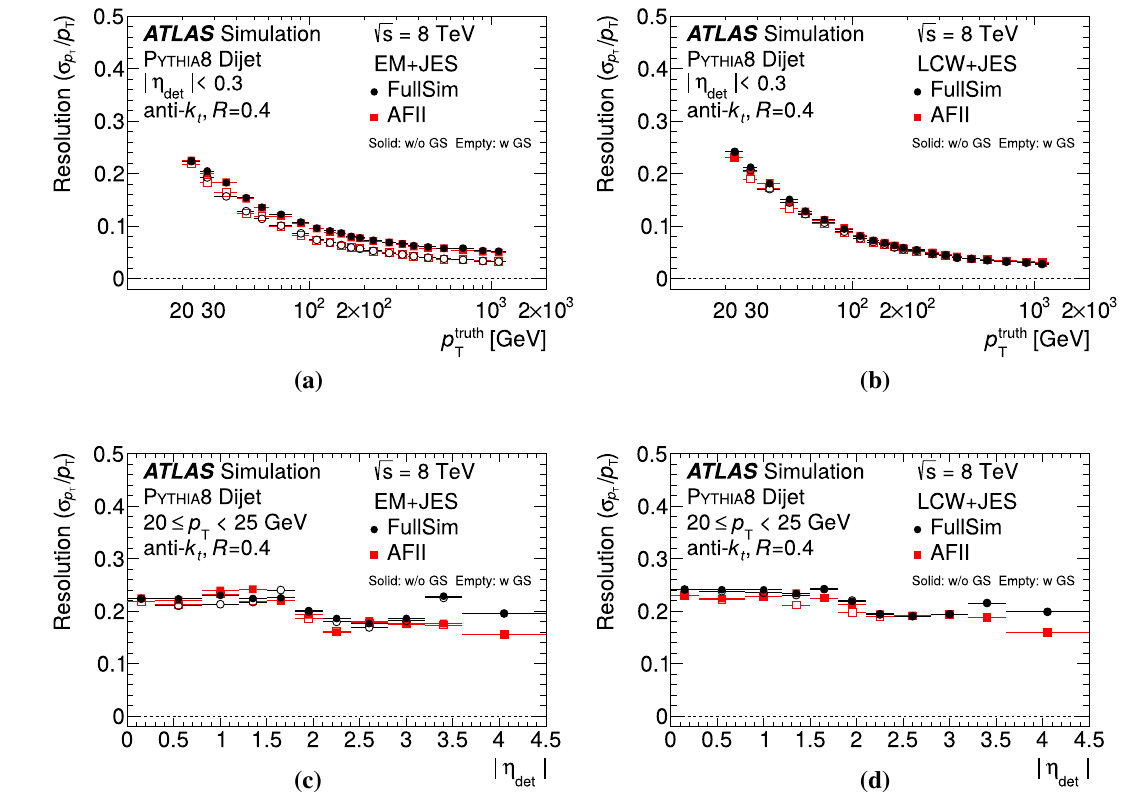
Fig. 49 Jet energy resolution measured in dijet MC samples as a func- tion of p truth for a EM+JES and b LCW+JES jets (filled markers). The T resolution in both events simulated with the full Geant 4 toolkit (cir- cles) and with fast simulation (squares) are shown. Additionally the